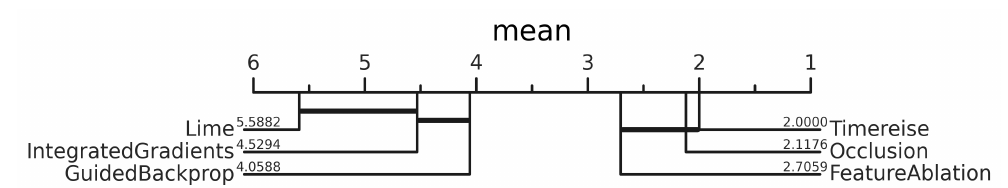
Figure 8. Sensitivity. A critical difference diagram showing the average rank of each attribution method across all datasets. The ranking is based on the average Sensitivity. Perturbation-based approaches show superior performance. The horizontal bars show the groups that can be concluded based on the rank of the methods. They clearly highlight the high and low performing sets.